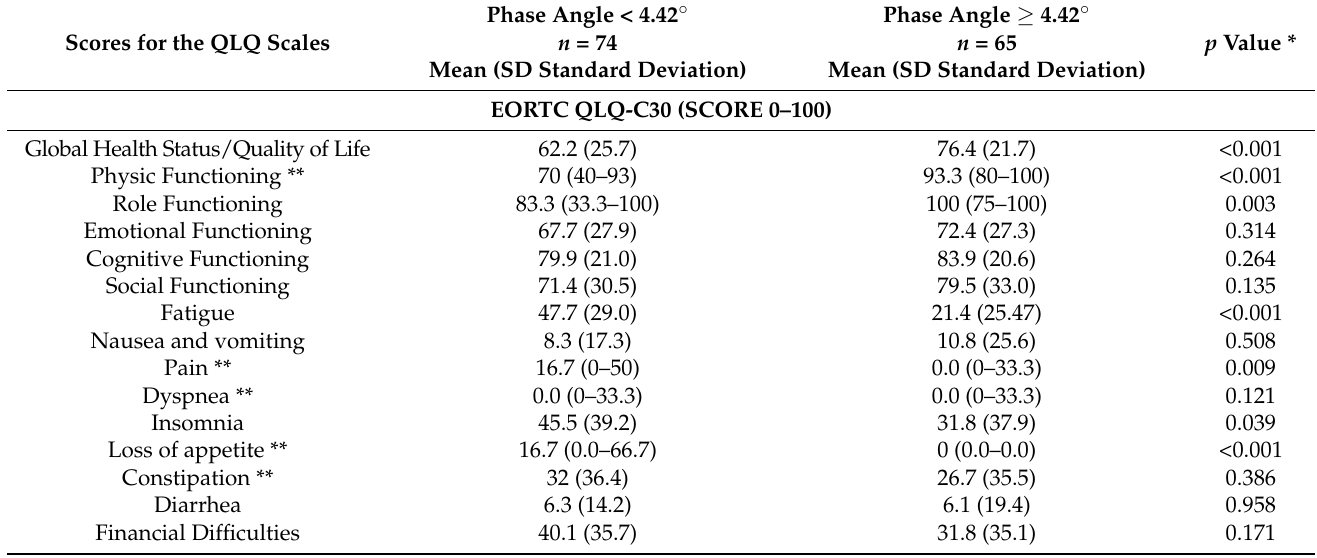
Table 3. EORTC QLQ-C30 and EORTC QLQ-H&N35 in the studied head and neck cancer patient